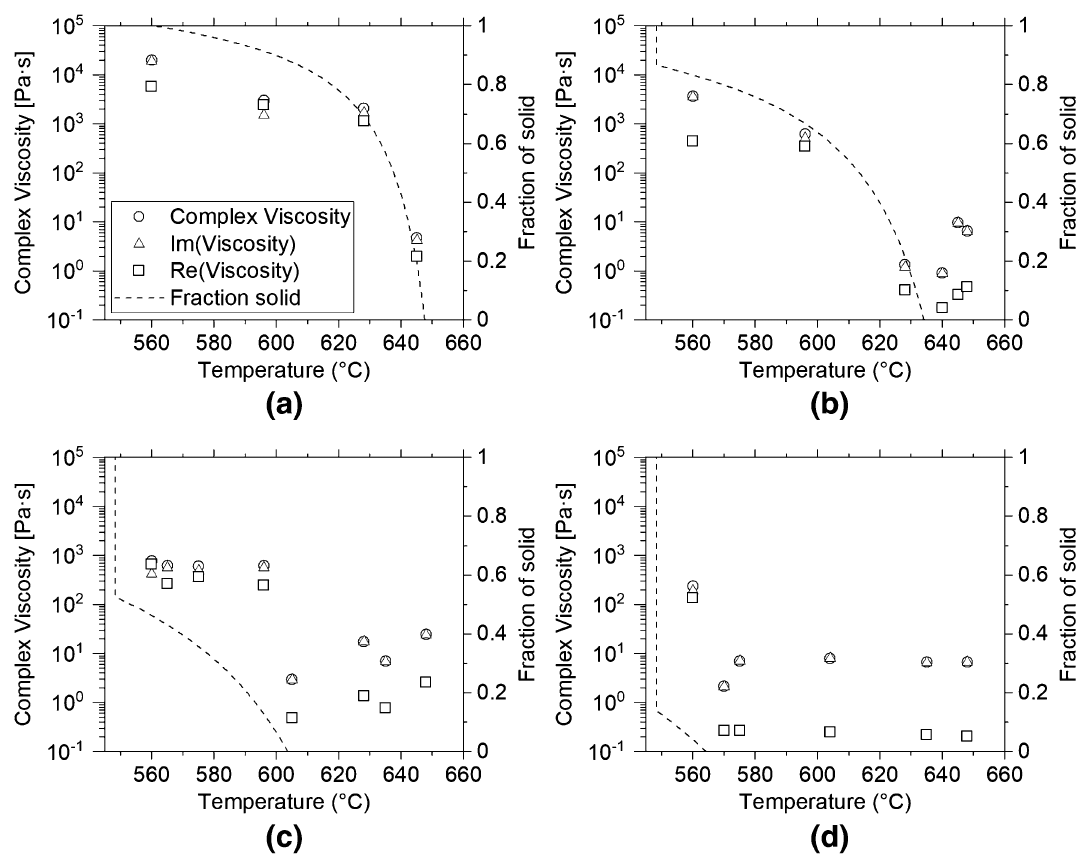
Fig. 9 Oscillatory measurements at an amplitude of 10 mrad and a frequency of 1 Hz- a 5%, b 10%, c 20% and d 30% (by weight)